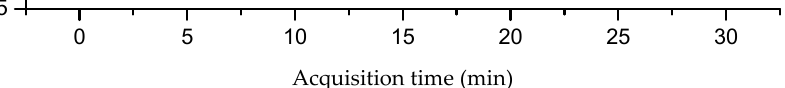
Figure 7. Temperature data collection of four test points at 25 °C, 50%, 0.1 m 3 /s.